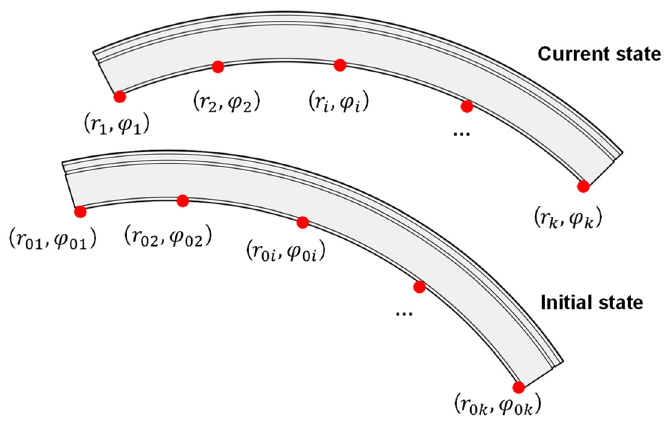
Figure 2. The schematic diagram of initial position and current position of segment.